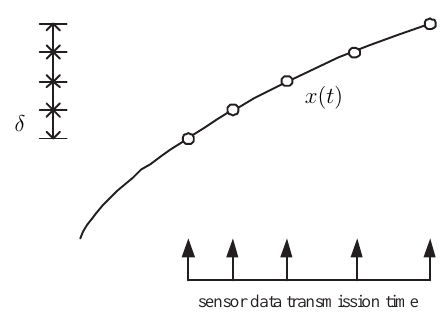
Figure 1 . Conventional send-on-delta transmission